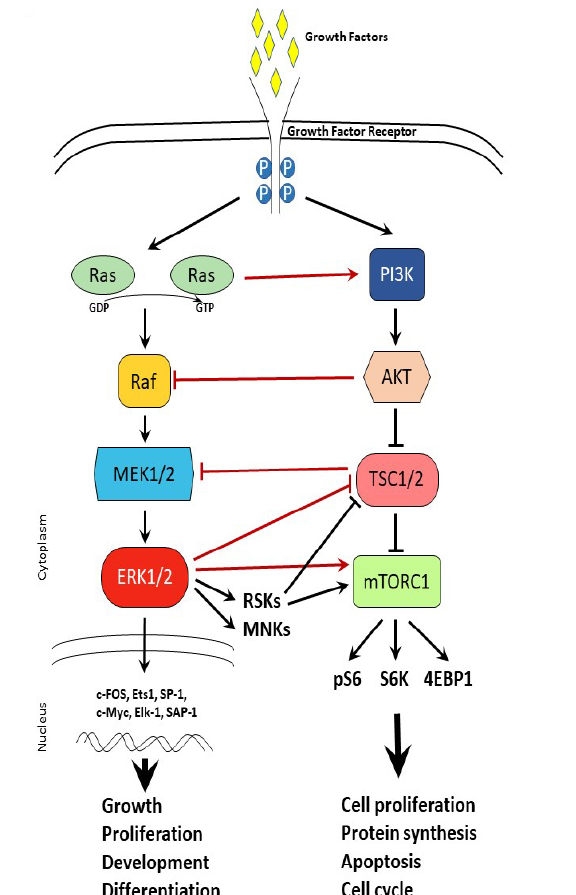
Figure 2. Cross-talk between MAPK and mTOR signaling pathways. Schematic representation of MAPK and mTOR signaling pathways upon growth factor activation. Arrows represent activation, while t-shaped lines represent inhibition. Black lines depict signaling within a pathway. Red lines depict crosstalk between signaling pathways. TSC1/2: tuberous sclerosis 1/2; 4EBP1: eukaryotic translation initiation factor 4E-binding protein 1; P: phosphorylation; pS6: phosphorylated S6; GDP: guanosine diphosphate; GTP: guanosine triphosphate